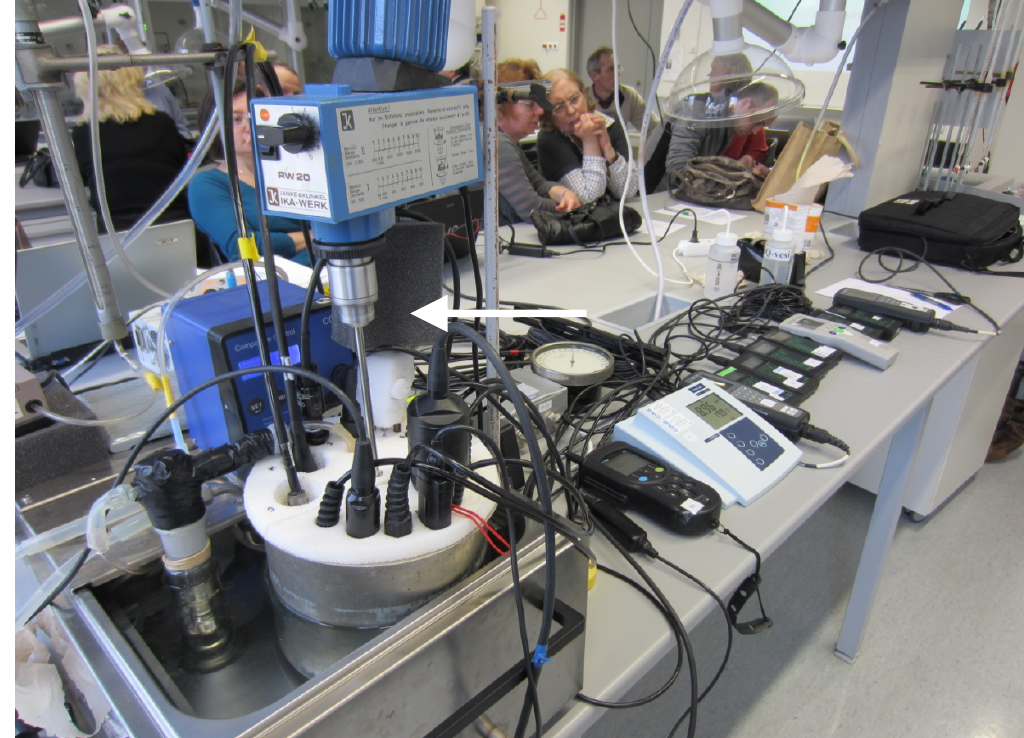
Figure 1. Photo of the experimental setup of dissolved oxygen intercomparison a